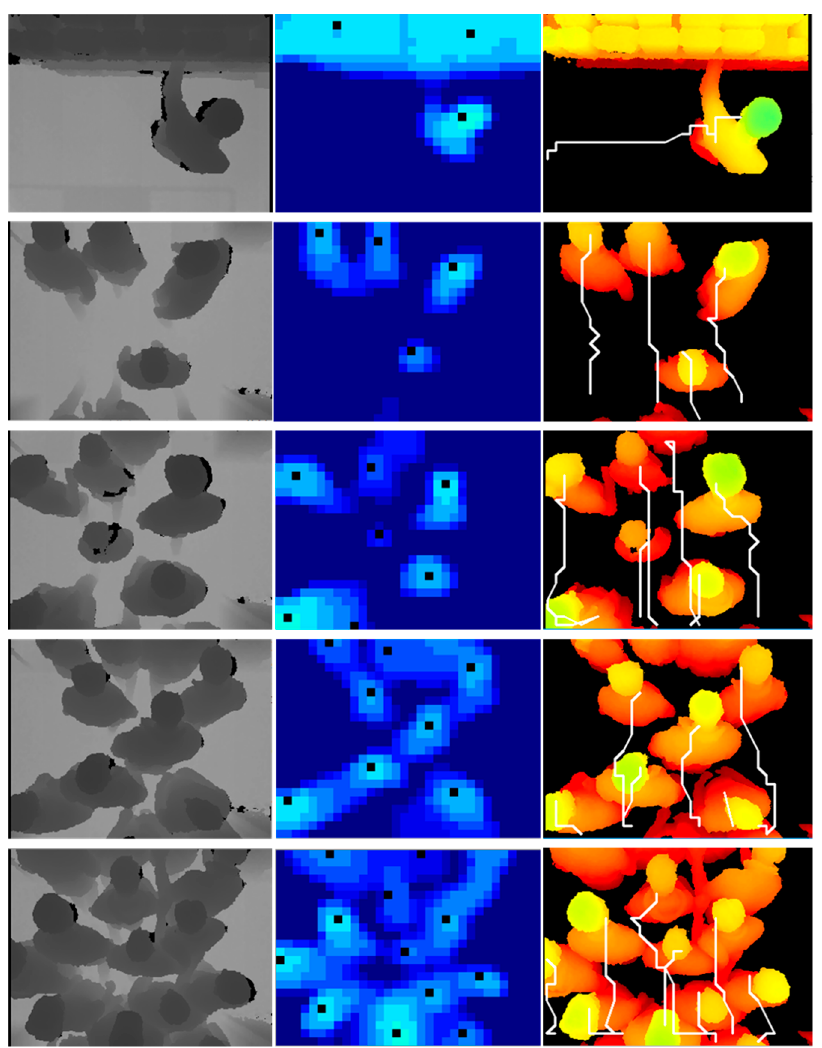
Figure 10. Performance of our human detection and flow estimation approach on the TVHeads dataset with 96.96% AP and 40 fps.